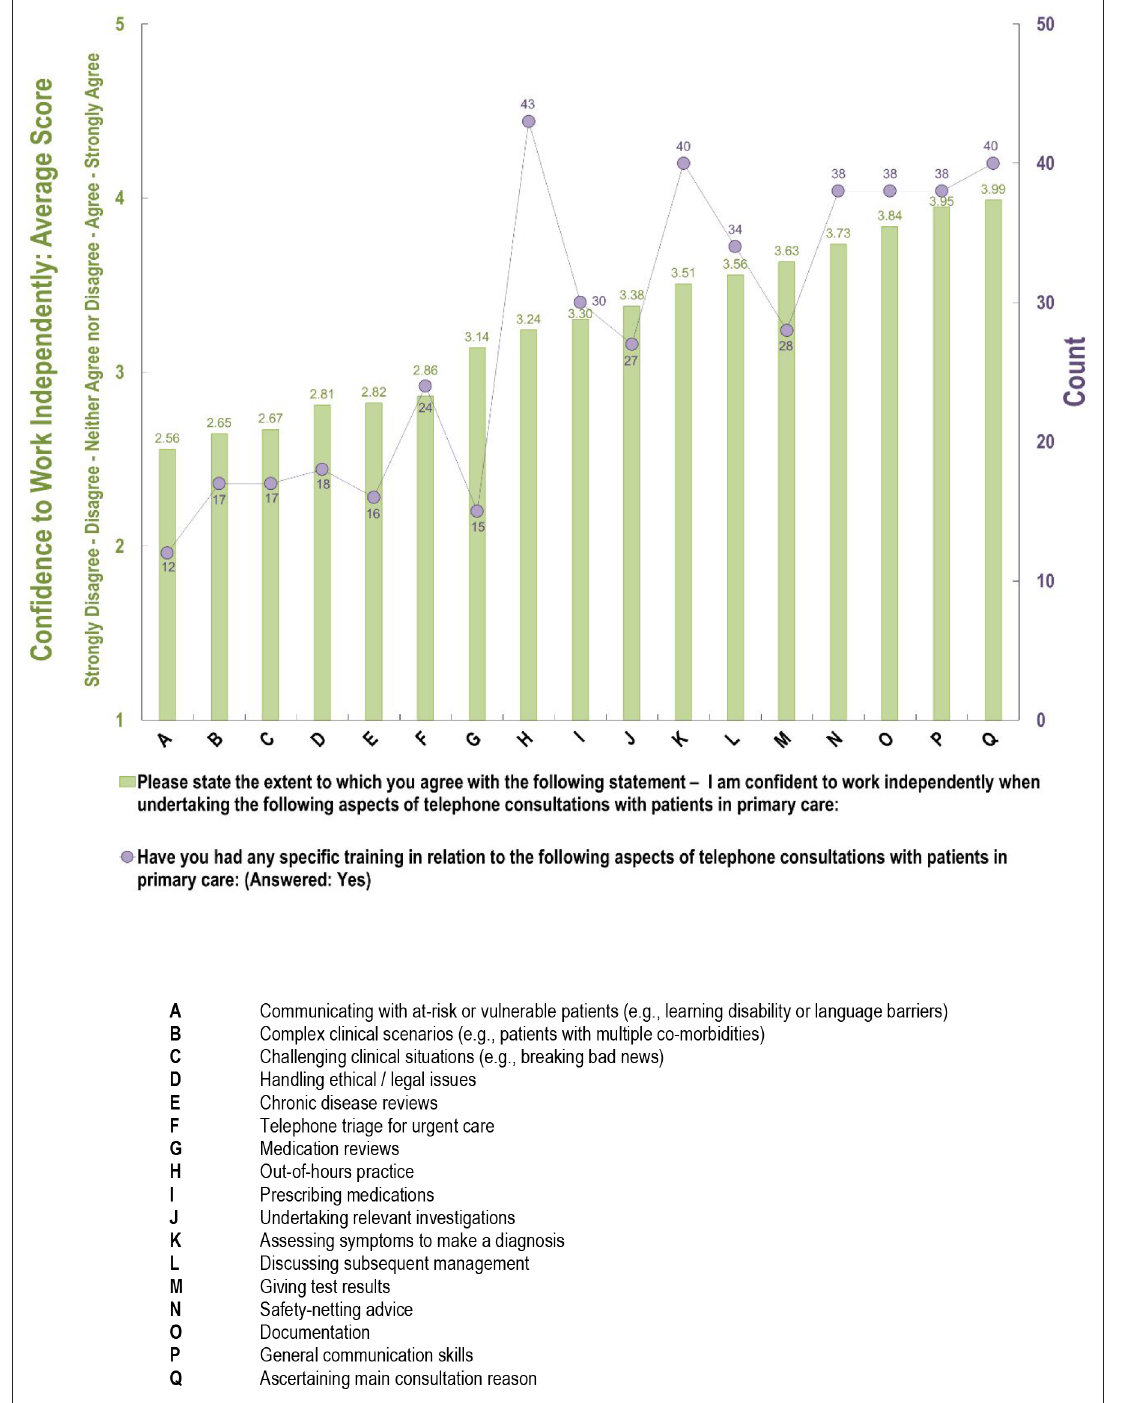
Figure 1 Confidence to work independently and prior training received across different aspects of telephone